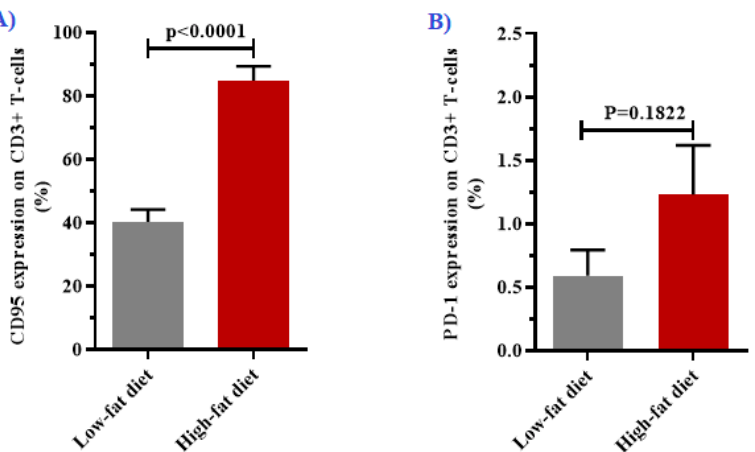
Figure 3. Changes in the expression of T-cell markers after 8 weeks of being on the respective diets ( n = 6/group). The high-fat diet (HFD)-fed group had increased levels of Fas (CD95) expression when compared with the low-fat diet (LFD)-fed group ( A ). However, programmed cell death 1 (PD-1) expression on CD3+ T-cells was comparable between the two groups ( B ). All data are presented as means ± standard error (SE).